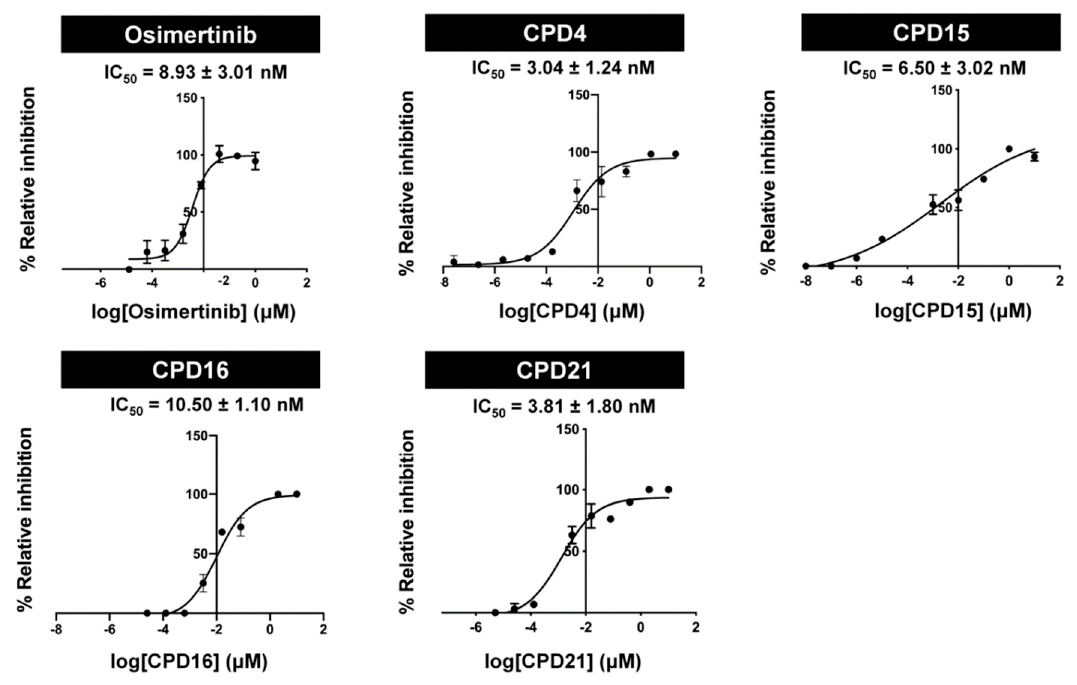
Figure 4. Dose–response curves of kinase inhibitory activity against EGFR (L858R/T790M/C797S) TK. Data were represented as mean ± SEM.